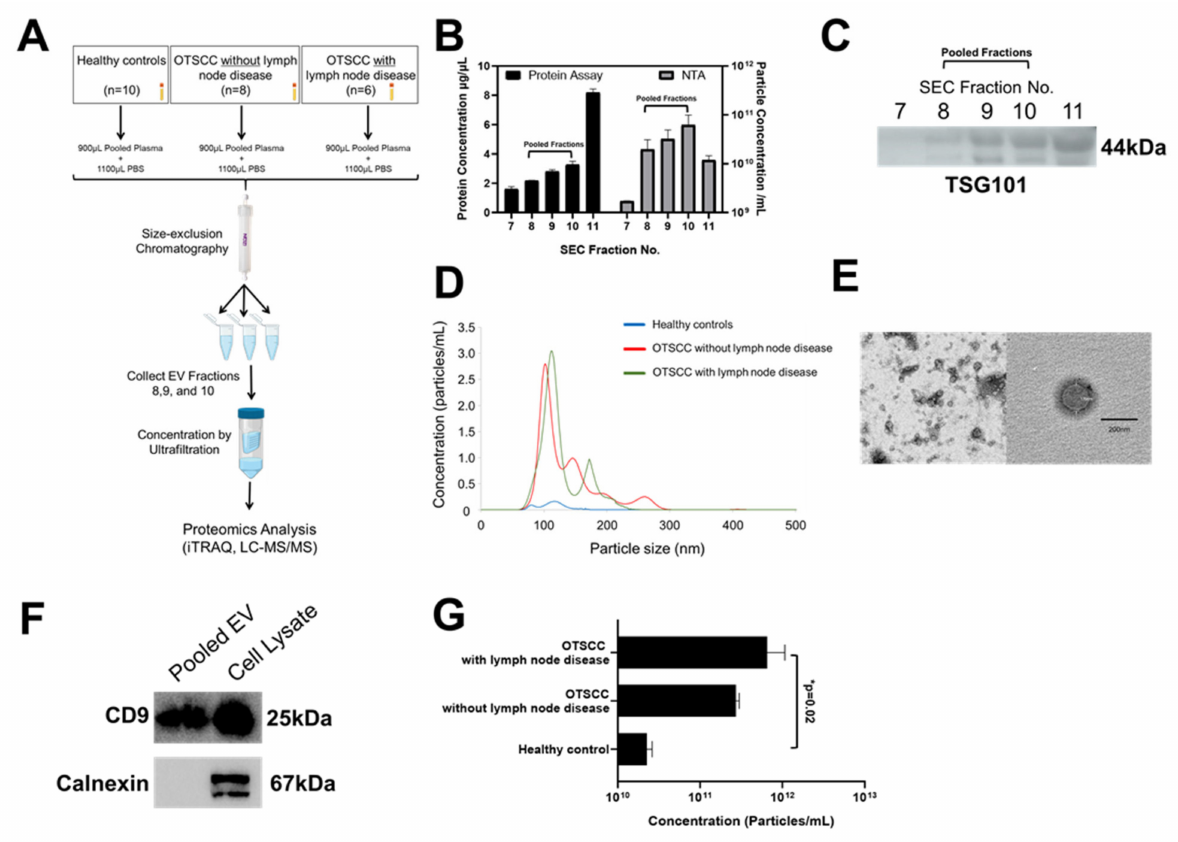
Figure 1. Validation of extracellular vesicle isolation using NTA, TEM, and Western blotting. ( A ) Overview of work flow. ( B ) NTA and protein quantitation indicated the mean particle concentration and crude protein concentration of EVs in SEC fractions 7–11. ( C ) Western blot results demonstrated the abundance of the EV positive marker TSG101 in SEC fractions 7–11. ( D ) NTA indicated the mean size distribution and particle concentration of EVs in each group. ( E ) Representative TEM image showed the characteristic rounded structure of EVs that are of the expected size. ( F ) Western blot results demonstrated the abundance of the EV positive marker CD9 SEC pooled fractions as well as whole cell lysate of an oral tongue cancer cell line (SCC25). Calnexin was negative in the EV preparations but positive in the cell lysate as expected. ( G ) Particle concentration was significantly greater in plasma from patients with node positive OTSCC relative to healthy controls. There was a reduction of EVs between OTSCC with and without nodal disease, but this trend was not